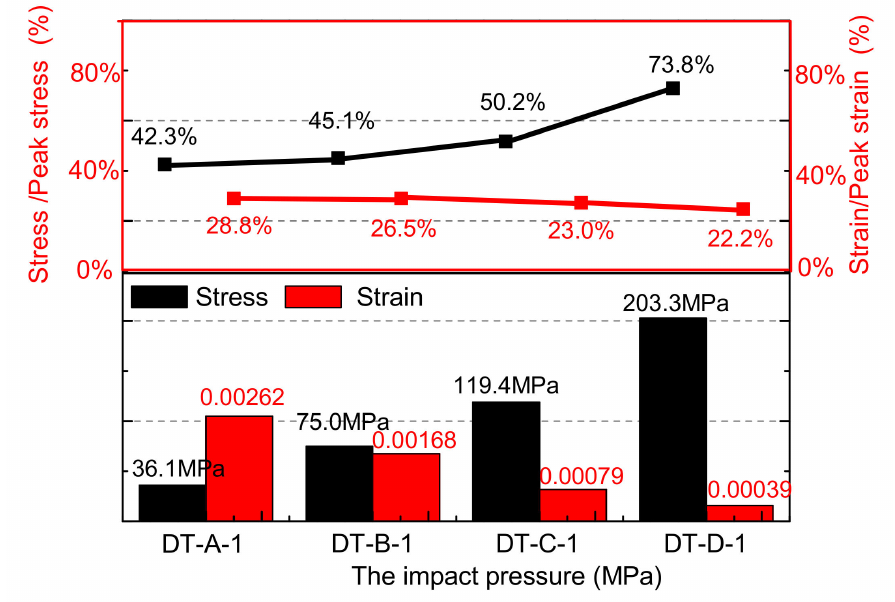
Figure 6. The effects of different loading speeds on stress–strain of samples.